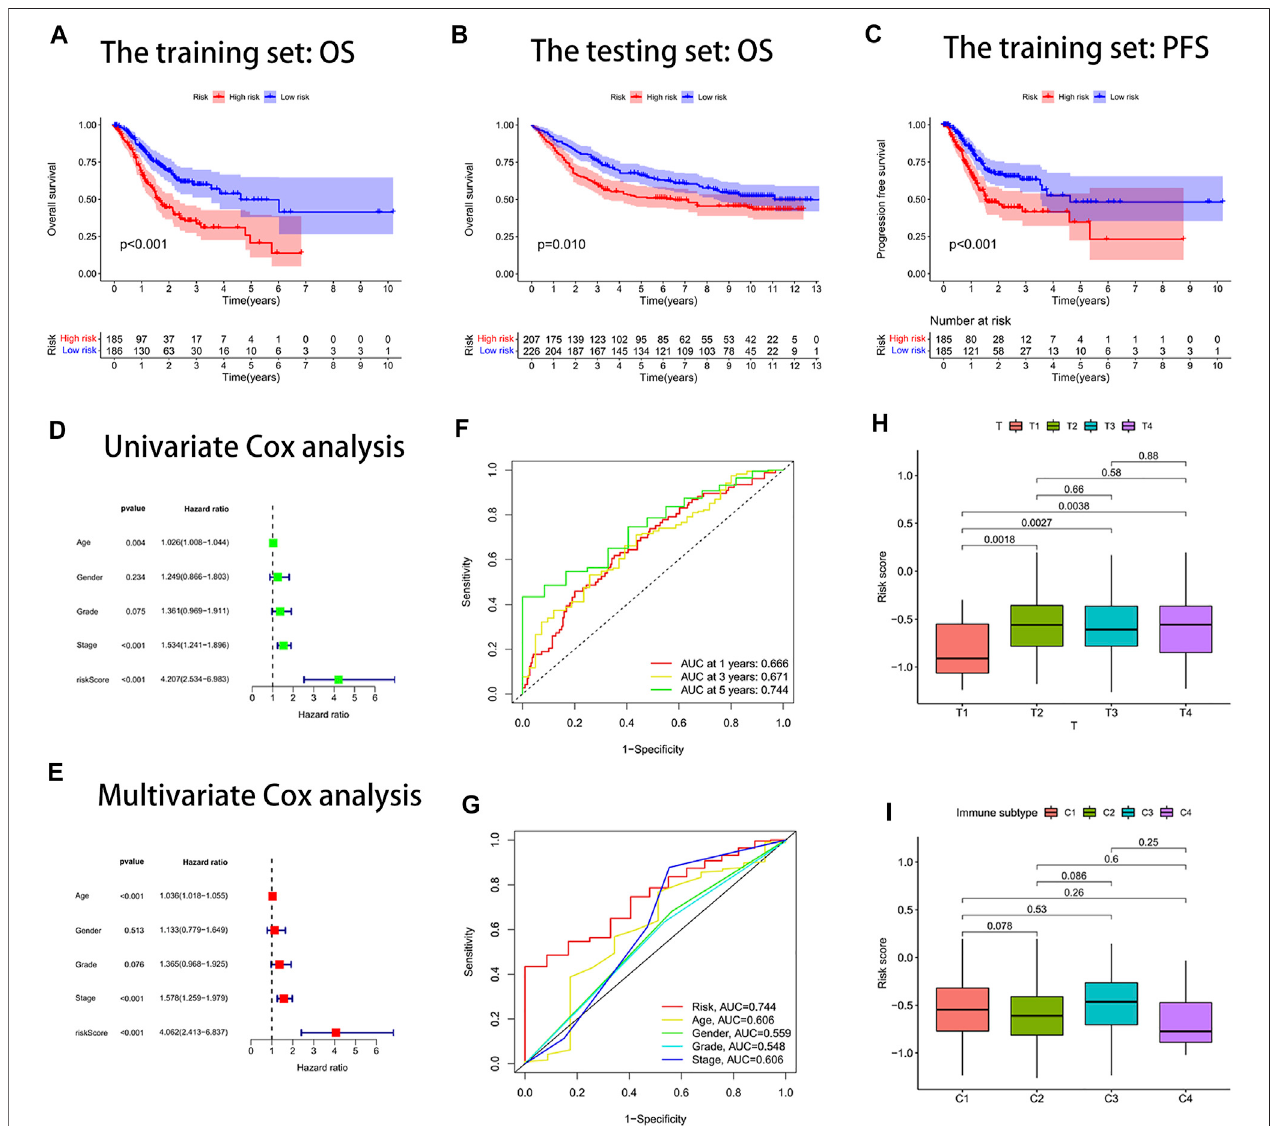
FIGURE3| Riskscoresignaturepredicted prognosisforgastriccancerpatients. (A) Overallsurvival(OS)curves ofthehigh-andlow-riskgroupsinthetrainingset. (B) Overallsurvival(OS)curvesofthehigh-andlow-riskgroupsinthetestingset. (C) Progression-freesurvival(PFS)curvesofthehigh-andlow-riskgroupsinthetraining set. (D) Univariate Cox analysis. (E) Multivariate Cox analysis. (F) Area under the ROC curve (AUC) for the risk score signature that predicted 1-year, 3-year, and 5-year overall survival. (G) ROC curves. The area under the ROC curve (AUC) for the risk score was the highest at 0.744. (H) Box plot of the difference in risk score for patients with different T-stages. (I) Box line plot of the difference in the risk score for patients with different immune subtypes.